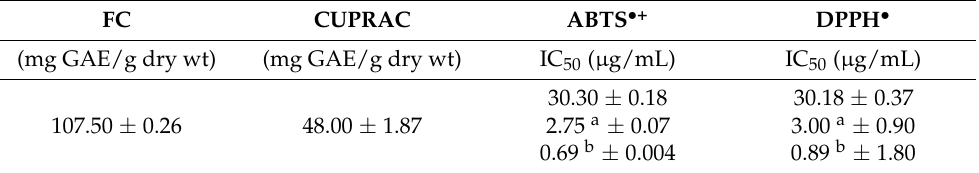
Table 1. The content of polyphenolic antioxidants in TML determined in the Folin–Ciocalteu (FC) and CUPRAC methods, and their antiradical properties evaluated in ABTS • + and DPPH • scavenging assays.